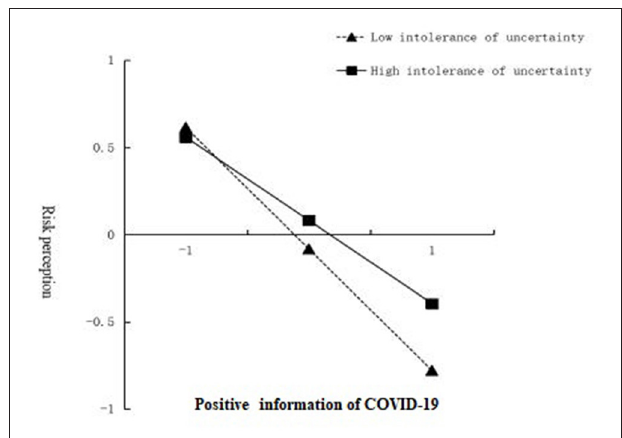
FIGURE 3 | Association between positive information of COVID-19 and risk perception at higher and lower levels of intolerance of uncertainty.